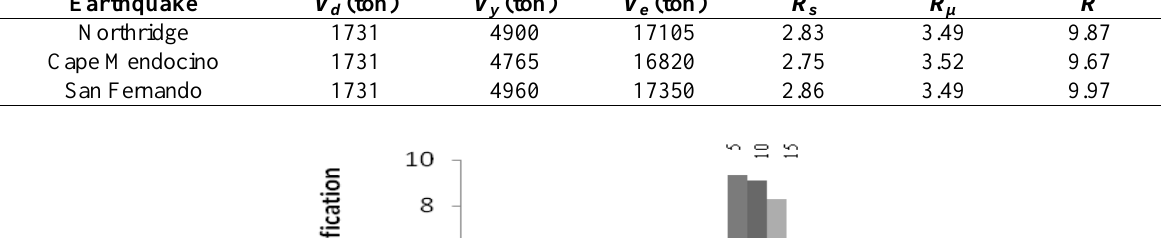
Table 4. Response modification factors for 5 story structure from time history analysis Earthquake